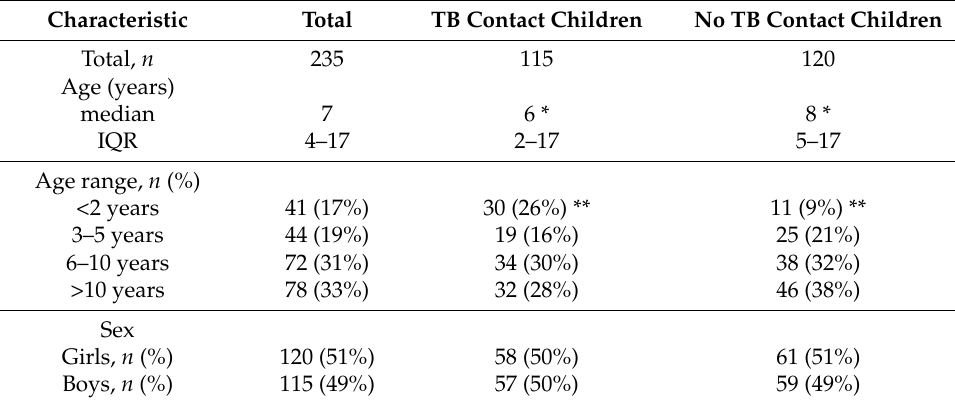
Table 1. Demographic characteristics of the study